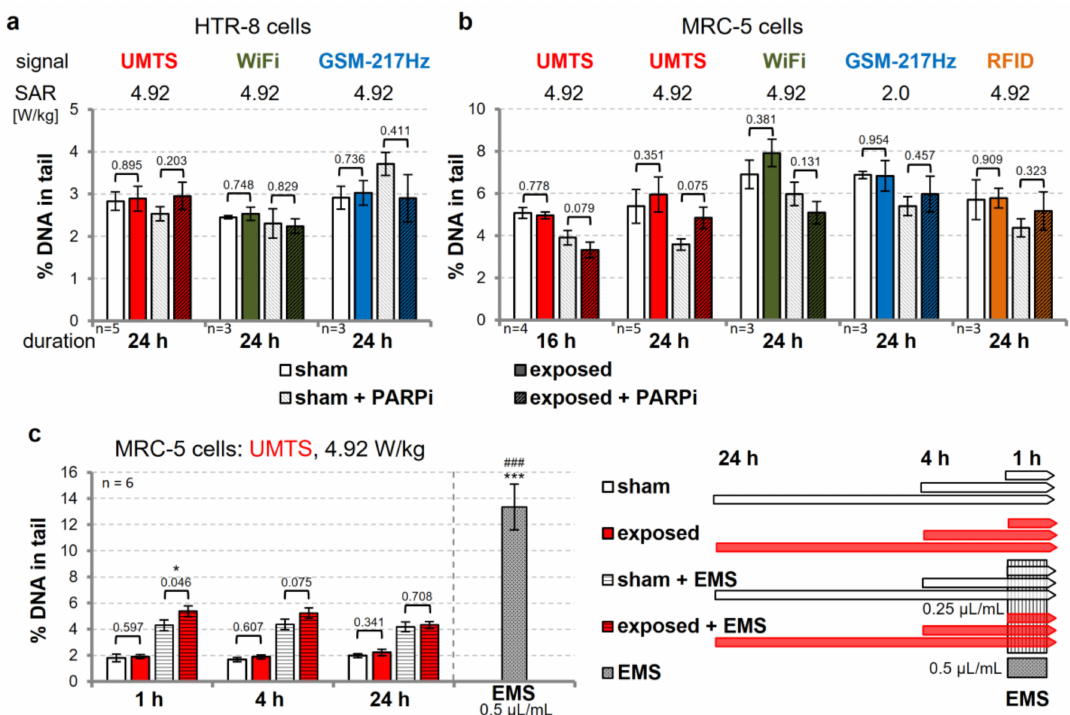
Figure 4. Reducing DNA base excision repair (BER) / single-strand break repair (SSBR) capacity and co-genotoxic treatment does not reveal DNA damage in wEMF-exposed cells. Human HTR-8 / SVneo trophoblasts ( a ) and primary MRC-5 lung fibroblasts ( b ) were exposed to intermittent (5 / 10 min on / o ff ) wEMF signals (colored bars by signal type) or sham-exposed (white bars) in the presence of 2 µ M PARP1 / 2 inhibitor AG-014699, as indicated. ( c ) Primary MRC-5 lung fibroblasts were exposed to an intermittent (5 / 10 min on / o ff ) Universal Mobile Telecommunications System (UMTS) signal (red bars) at 4.92 W / kg SAR or sham-exposed (white bars) for the duration indicated. During the last 1 h of exposure, half of the samples were treated with 0.25 µ L / mL of ethyl methanesulfonate (EMS). To assess dose response, unexposed cells were incubated with 0.5 µ L / mL EMS for 1 h. DNA damage levels were assessed by the alkaline CA. Shown are the arithmetic means ± SEM of the indicated number of independent experiments. The significance level ( p -values) of paired Student´s t -tests are given, comparing sham- and wEMF-exposed cells. Asterisks and hashes represent the significance levels: * p ≤ 0.05, *** ,### p < 0.001, comparing the positive control EMS with the matched sham exposure and sham + EMS samples,